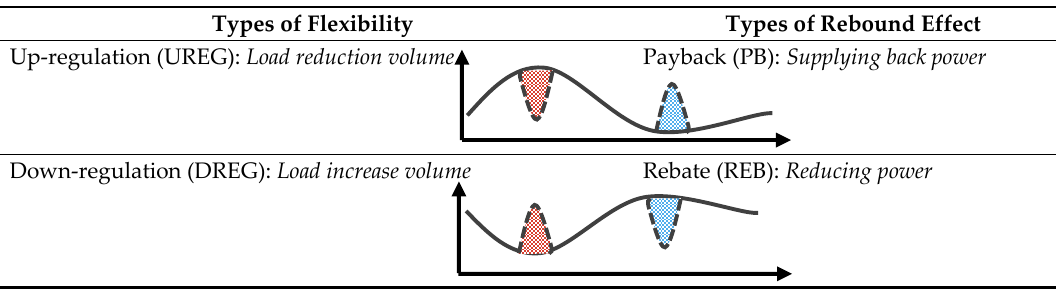
Table 1. Summary of DSF types.